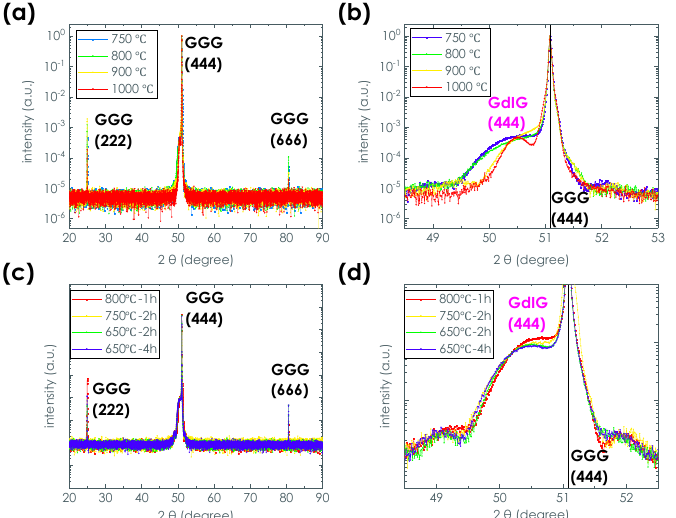
Figure 1. XRD spectrum for GdIG samples annealed at various annealing temperatures ( a ) from 20 ◦ to 90 ◦ and ( b ) from 48.5 ◦ to 53 ◦ . XRD spectrum for GdIG samples annealed at various annealing times ( c ) from 20 ◦ to 90 ◦ and ( d ) from 48.5 ◦ to 53 ◦ .